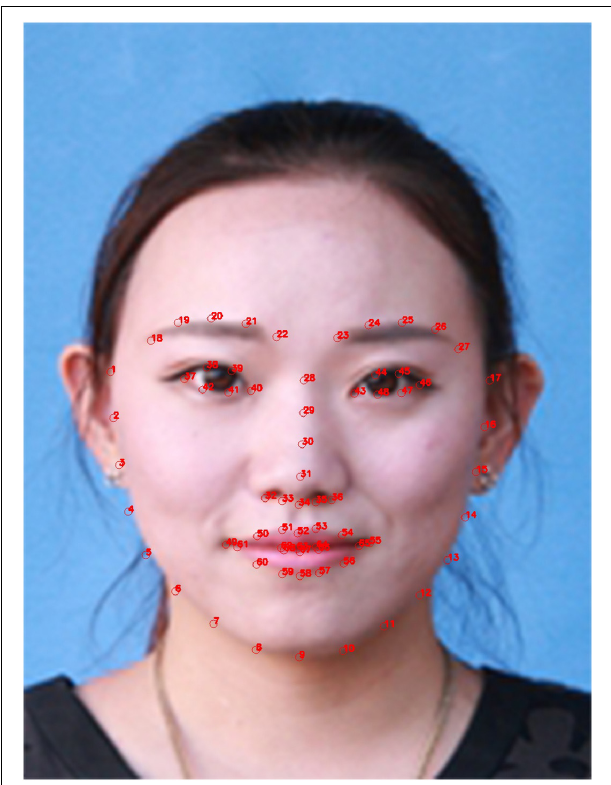
FIGURE 2 | Facial marked point image (Clarification: written informed consent was obtained from the individual for the publication of this